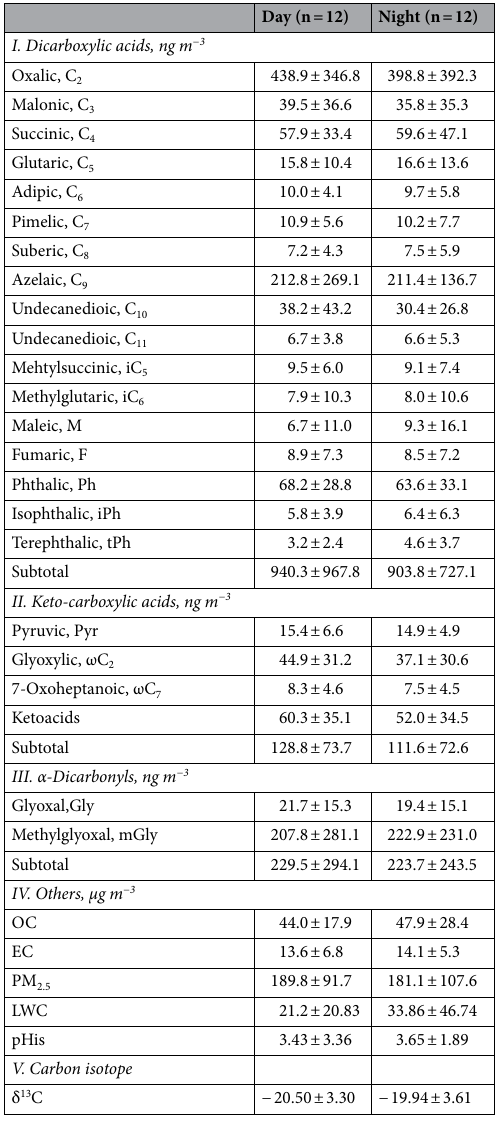
Table 1. Concentrations of dicarboxylic acids, keto-carboxylic acids, α-dicarbonyls, OC, and EC in PM 2.5 of Weinan, China by day and